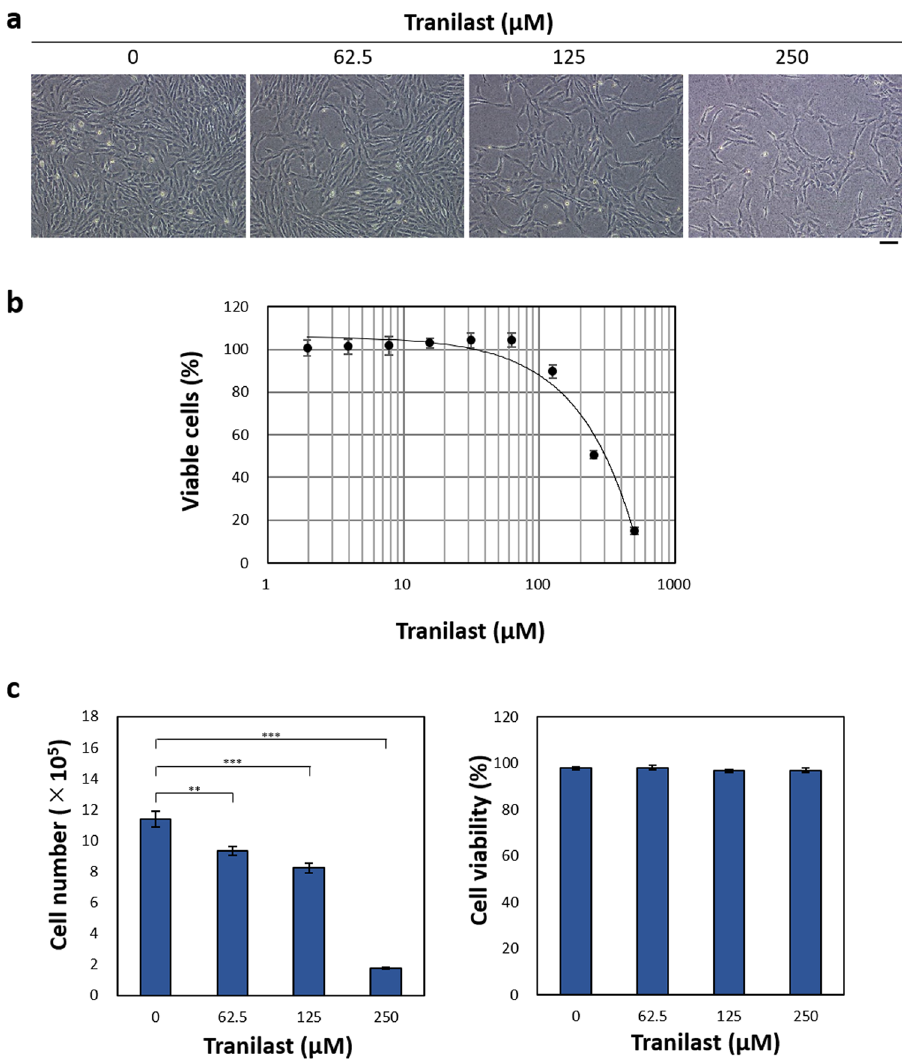
Figure 3. Tranilast inhibits sNF96.2 cell proliferation. ( a ) Phase-contrast microscopy of sNF96.2 cells treated with the indicated concentrations of tranilast for 48 h. Scale bar, 100 µ m. ( b ) Concentration-response curve for the inhibition of sNF96.2 cell proliferation determined by measurement of the number of viable cells with the CellTiter-Glo (Promega) assay after exposure of the cells to the drug for 48 h. Data are means ± s.d. for six replicates from a representative experiment. ( c ) sNF96.2 cells were treated with the indicated concentrations of tranilast for 48 h, after which the number of viable cells and the percentage of viable cells were determined on the basis of trypan blue exclusion. Data are means ± s.d. for triplicates from a representative experiment. ** P < 0.01 (Student’s unpaired t